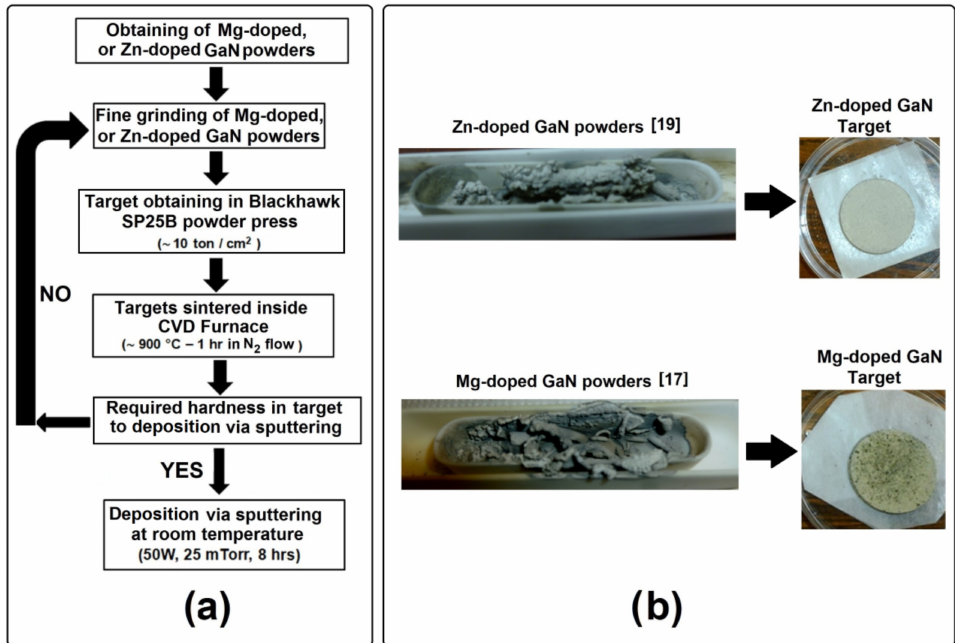
Figure 1. ( a ) Process diagram to obtain the Mg- or Zn-doped GaN films; ( b ) Laboratory-prepared targets using Mg- or Zn-doped